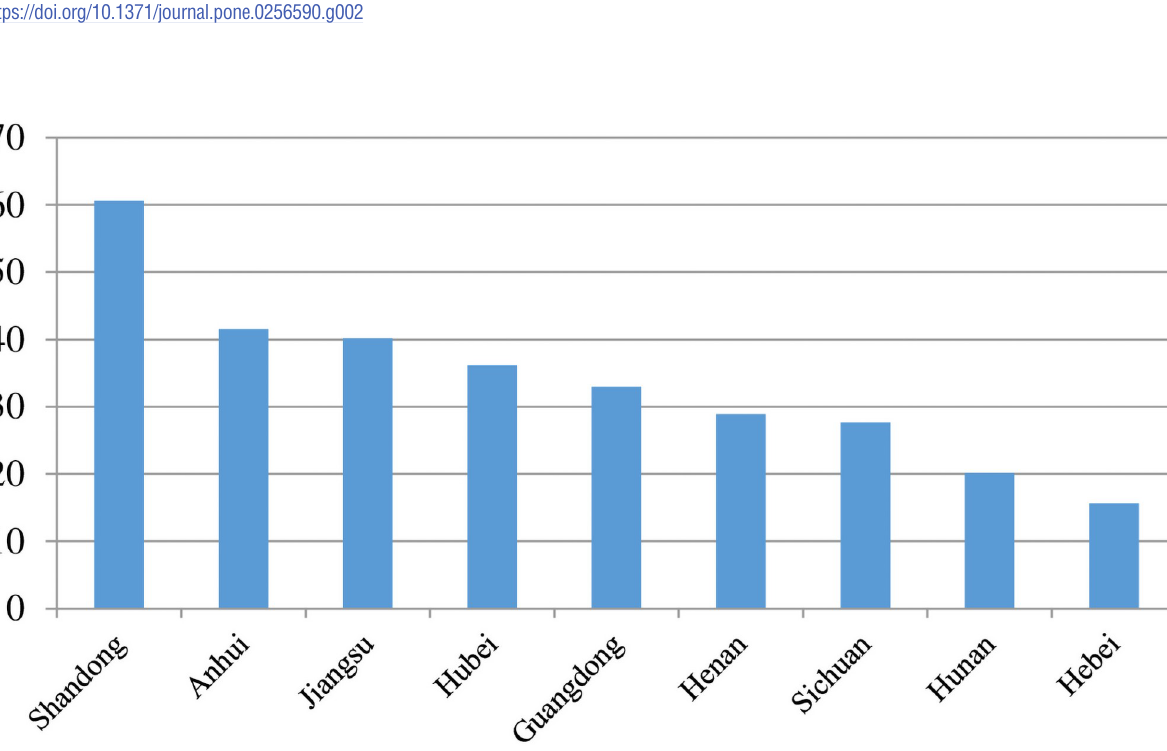
PLOS ONE | https://doi.org/10.1371/journal.pone.0256590 September 30, 2021 6 /